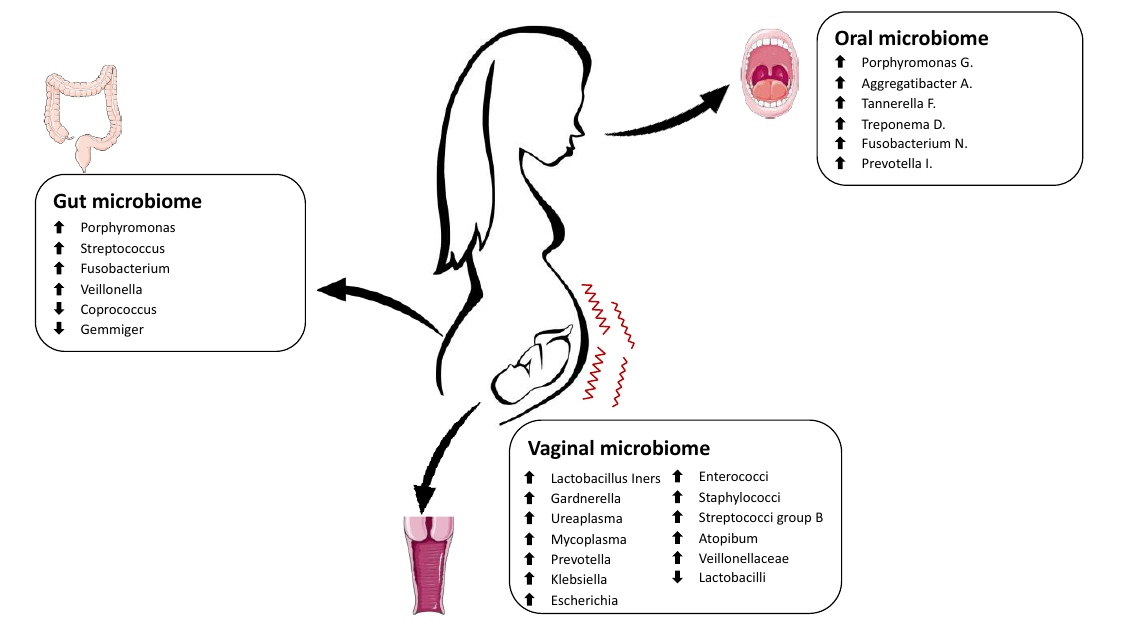
Figure 4. Schematic representation of the main alterations in the maternal microbiome in pregnancies complicated by preterm birth. The Figure was partly generated using Servier Medical Art, provided by Servier, licensed under a Creative Commons Attribution 3.0 unported license.